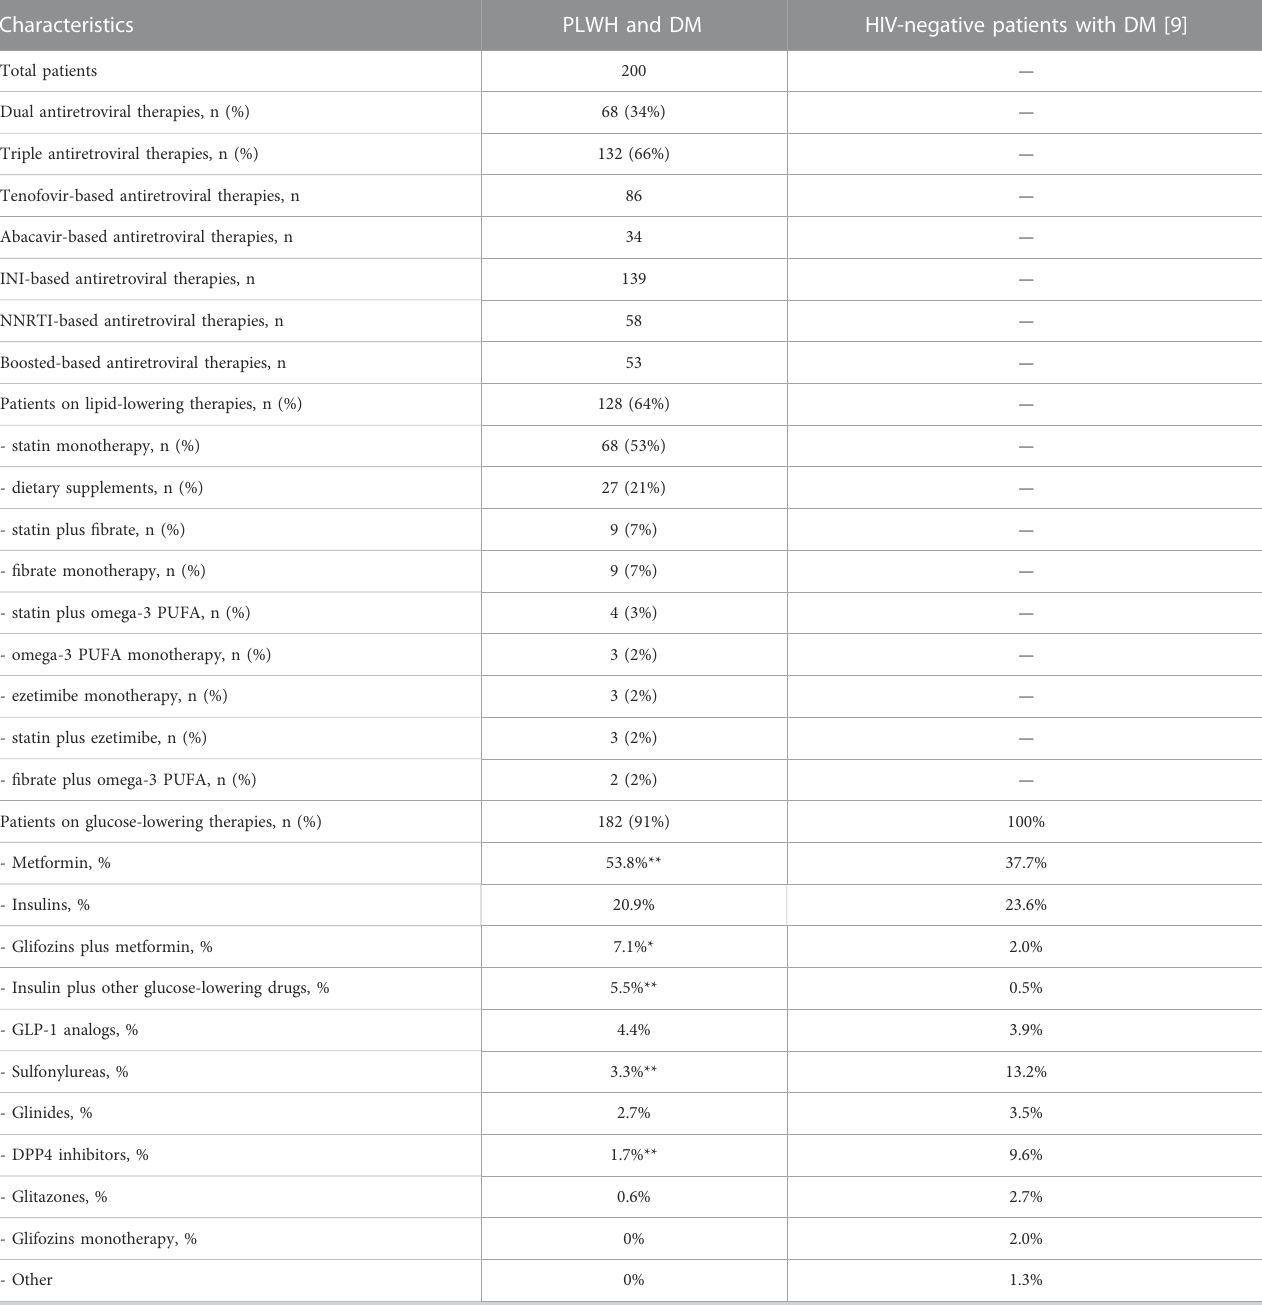
TABLE 2 Therapies for the treatment of HIV, dyslipidemias and diabetes mellitus.